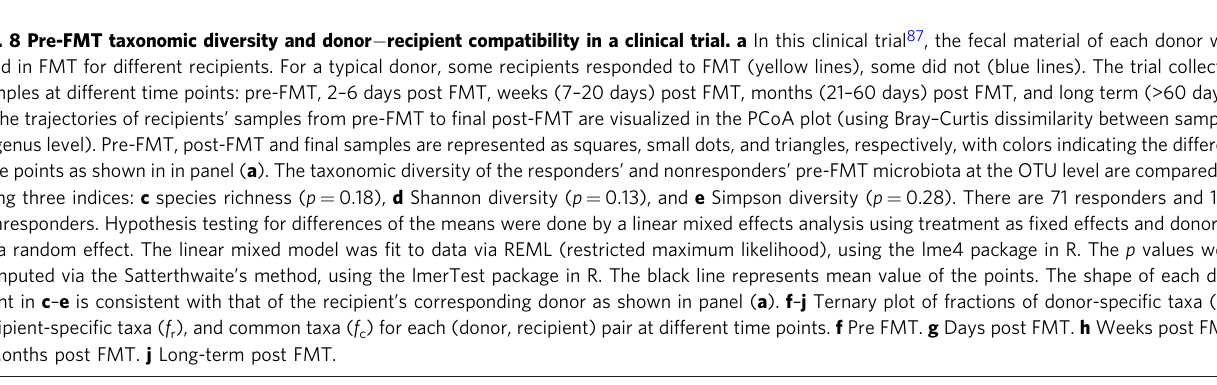
Fig. 8 Pre-FMT taxonomic diversity and donor − recipient compatibility in a clinical trial. a In this clinical trial 87 , the fecal material of each donor was used in FMT for different recipients. For a typical donor, some recipients responded to FMT (yellow lines), some did not (blue lines). The trial collected samples at different time points: pre-FMT, 2 – 6 days post FMT, weeks (7 – 20 days) post FMT, months (21 – 60 days) post FMT, and long term (>60 days). b The trajectories of recipients ’ samples from pre-FMT to fi nal post-FMT are visualized in the PCoA plot (using Bray – Curtis dissimilarity between samples at genus level). Pre-FMT, post-FMT and fi nal samples are represented as squares, small dots, and triangles, respectively, with colors indicating the different time points as shown in in panel ( a ). The taxonomic diversity of the responders ’ and nonresponders ’ pre-FMT microbiota at the OTU level are compared by using three indices: c species richness ( p = 0.18), d Shannon diversity ( p = 0.13), and e Simpson diversity ( p = 0.28). There are 71 responders and 17 nonresponders. Hypothesis testing for differences of the means were done by a linear mixed effects analysis using treatment as fi xed effects and donor